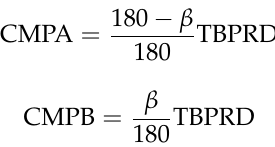
Figure 5. Typical synchronization waveforms.